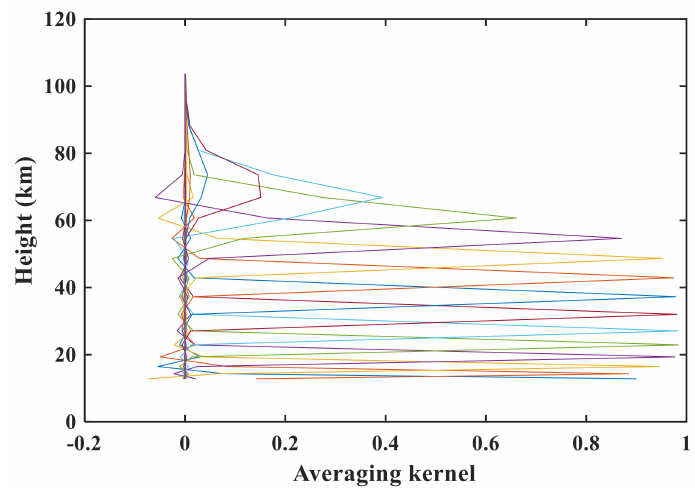
Figure 17. HF averaging kernel for